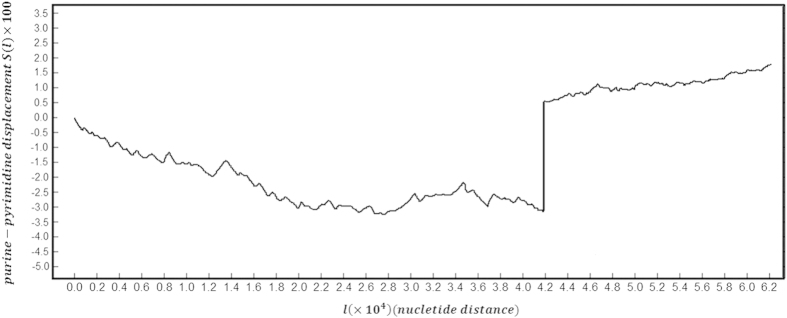
The real damaged DNA walk and solution of Equation (13) (after l = 4.2).